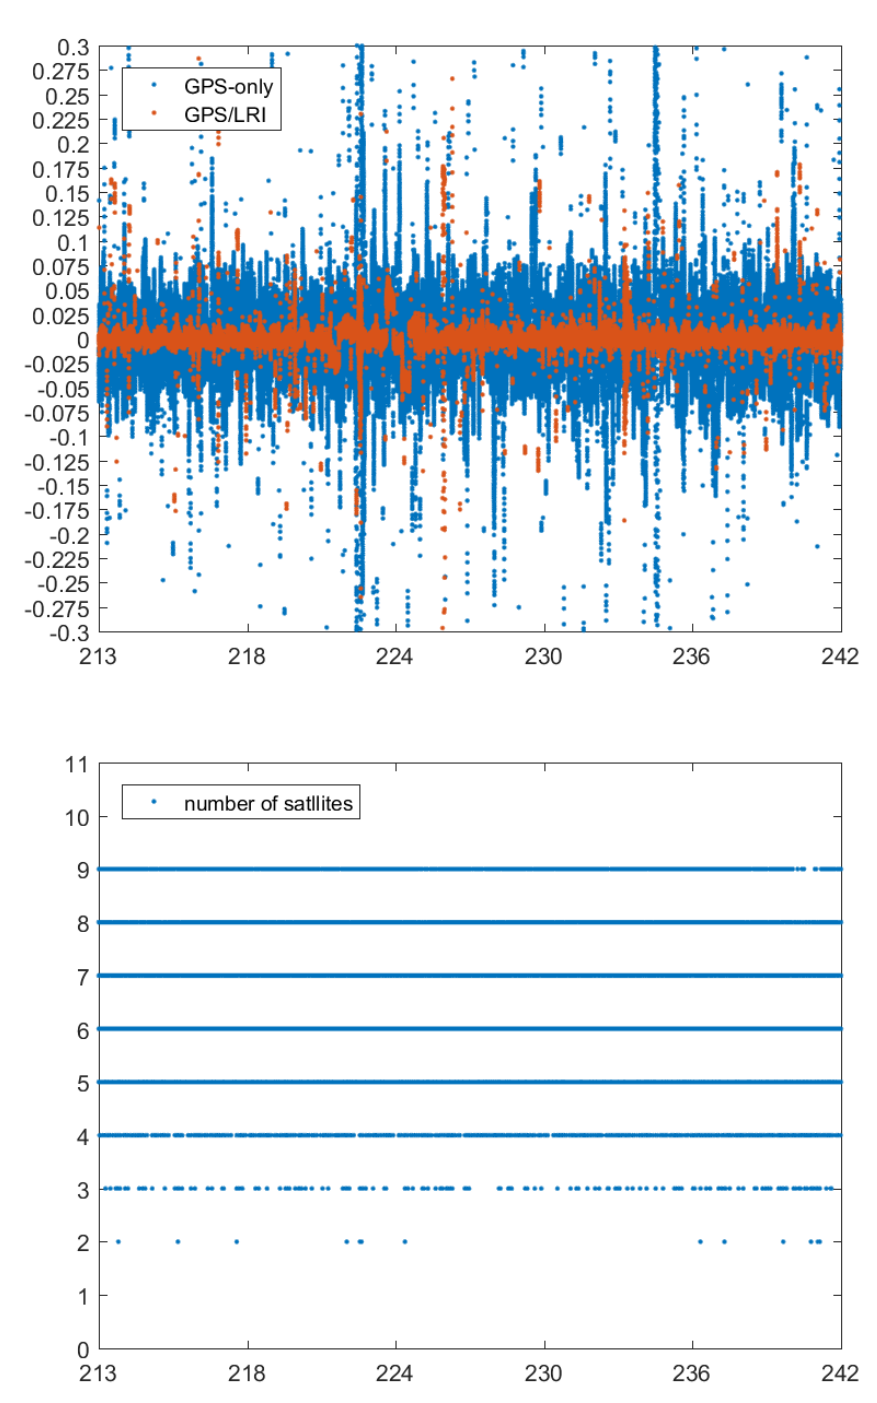
Figure 18. Day 213–242 KBR residuals (unit: m) for the GPS/LRI and GPS-only relative orbit and number of satellites.